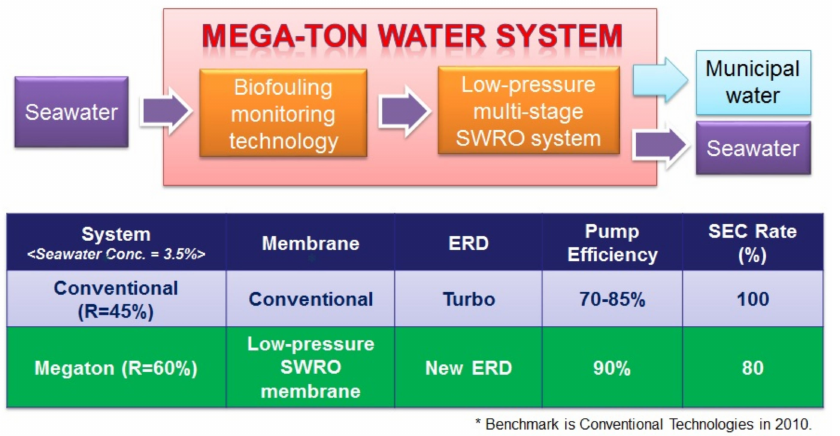
Figure 15. SEC Rate (%) comparison of conventional SWRO and Mega-ton System (LMS) [25–27]. Although Miguel Sanz has reported the historical trends of the energy consumption of the total plant and the 1st RO pass. In the “Mega-ton Water System” project, the target value of energy consumption as a total plant under TDS 35,000 mg/L seawater concentration was set to 2.80 kWh/m 3 or less. In this case, it is possible to reduce energy by 20% compared with the conventional system [25–27].